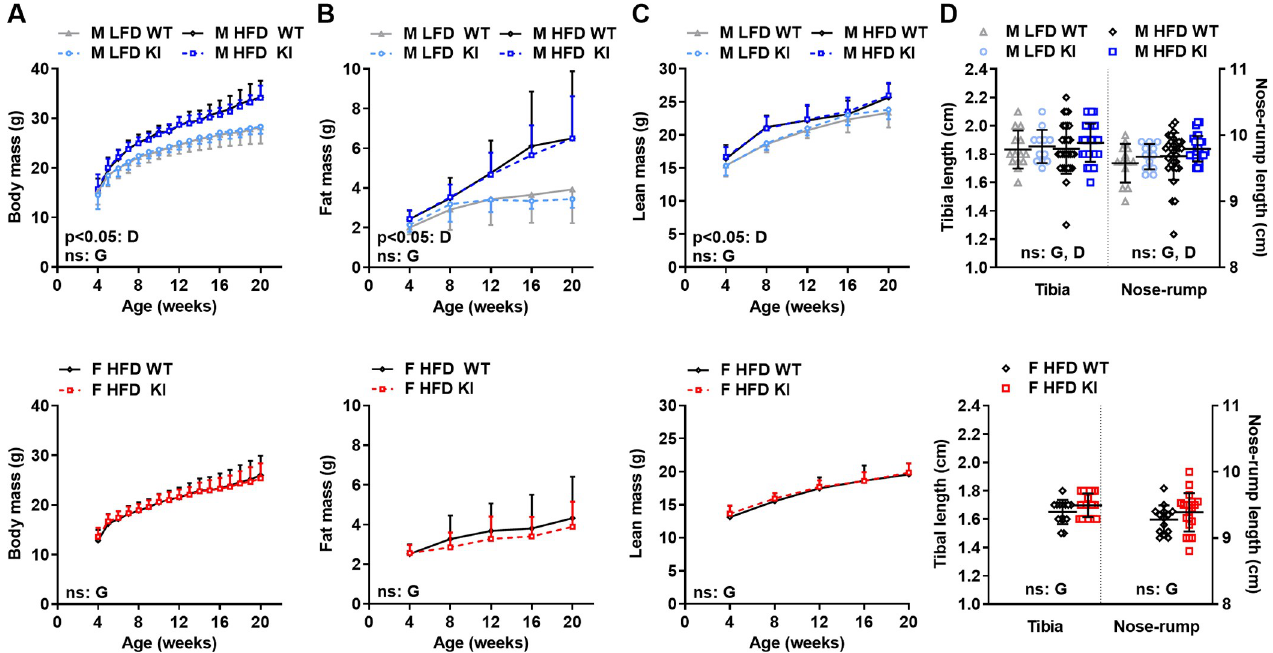
Fig 2. Effect of the CREBRF R458Q variant on body weight, body composition, and linear growth on control diet (low-fat diet) and in response to chronic nutritional overload (high-fat diet) in mice. Male (M, top row, n = 12-14/group for LFD and 18/group for HFD) and female (F, bottom row, n = 30-42/ group) wild-type (WT) and knockin (KI) mice were fed low-fat diet (LFD) or high-fat diet (HFD) weaning until sacrifice at 22 weeks of age (or 36 weeks of age in Fig 5). Total body mass ( A ), fat mass ( B ), and lean mass ( C ) were determined at the ages indicated. Tibia and Nose-rump length ( D ) were determined at 22 weeks of age (M, n = 12-14/group for LFD and 30-31/group for HFD; F n = 14-20/group). General linear models with ( A-C ) or without ( D ) time as a within subject variable were used to compare the above dependent variables between D = diet (LFD, HFD) and G = genotype (WT, KI) as fixed factors. Data are mean (SD). Main effects with a significance level of p < 0.05 are indicated. Main effects with a significance level of � 0.05 are labeled as non-significant (ns).